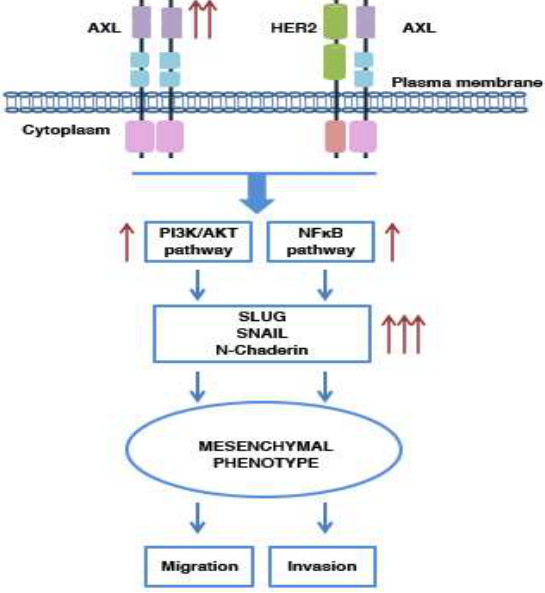
Figure 4. AXL involvement in the EMT process. In breast cancers, AXL is crucial for disease progression and is involved in the regulation of the EMT process. This receptor, when activated in a manner that is GAS6-dependent or not, induces the PI3K and NFkB pathways’ activation, implicated in cell mesenchymal state transition. These conditions determine an increase in migration and invasive properties of the breast cancer